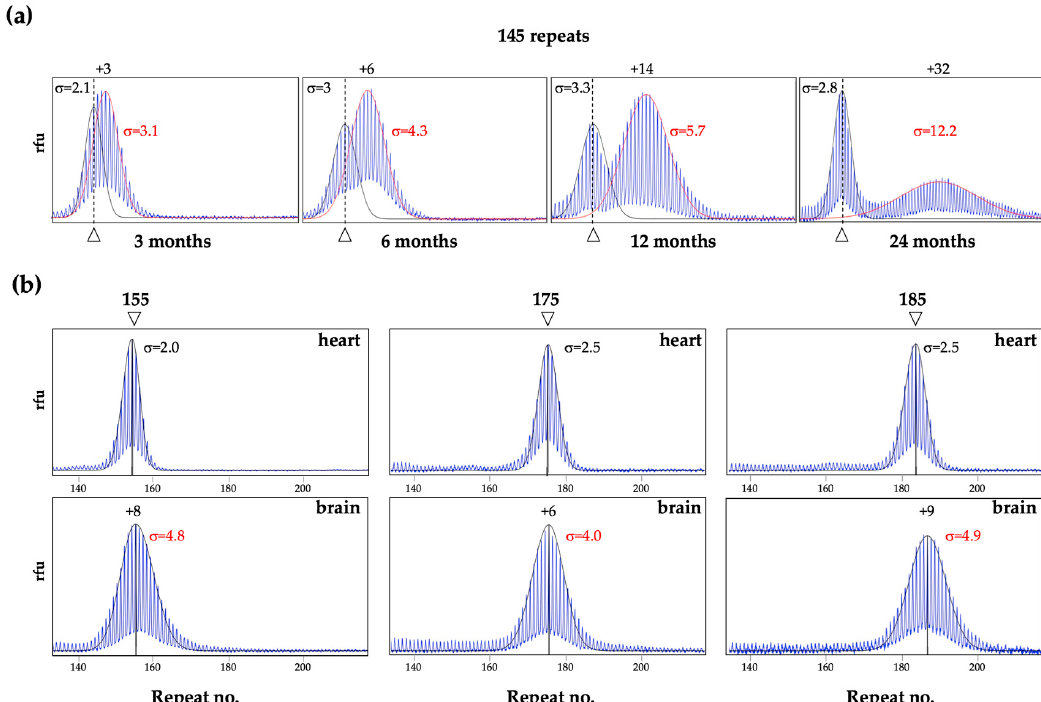
Figure 2. Change in the PM repeat PCR profiles and σ with age and extent of expansion. The PCR profiles and σ s were generated from male mice as previously described [26,27]. ( a ) Liver PCR profiles of mice of different ages, all with an original allele of ~145 repeats. The arrowhead on the bottom of each panel and the dotted lines indicate the original inherited allele as assessed from tail DNA taken at 3 weeks of age. The numbers above the panels indicate the number of repeats added to the expanded allele. The σ of the stable allele and the expanded allele are shown in black and red, respectively. The examples shown in this panel are derived from previously published work [27]; ( b ) PCR profiles and corresponding σ for alleles in hearts and brains of 1-year old (155 repeats) and 6-month old (175 and 185 repeats) mice. The number associated with each arrowhead represents the number of repeats in the indicated allele. For the hearts, this number corresponds to the original inherited allele. For the brains, the repeat size reflects a gain of 6–9 repeats from the original allele.